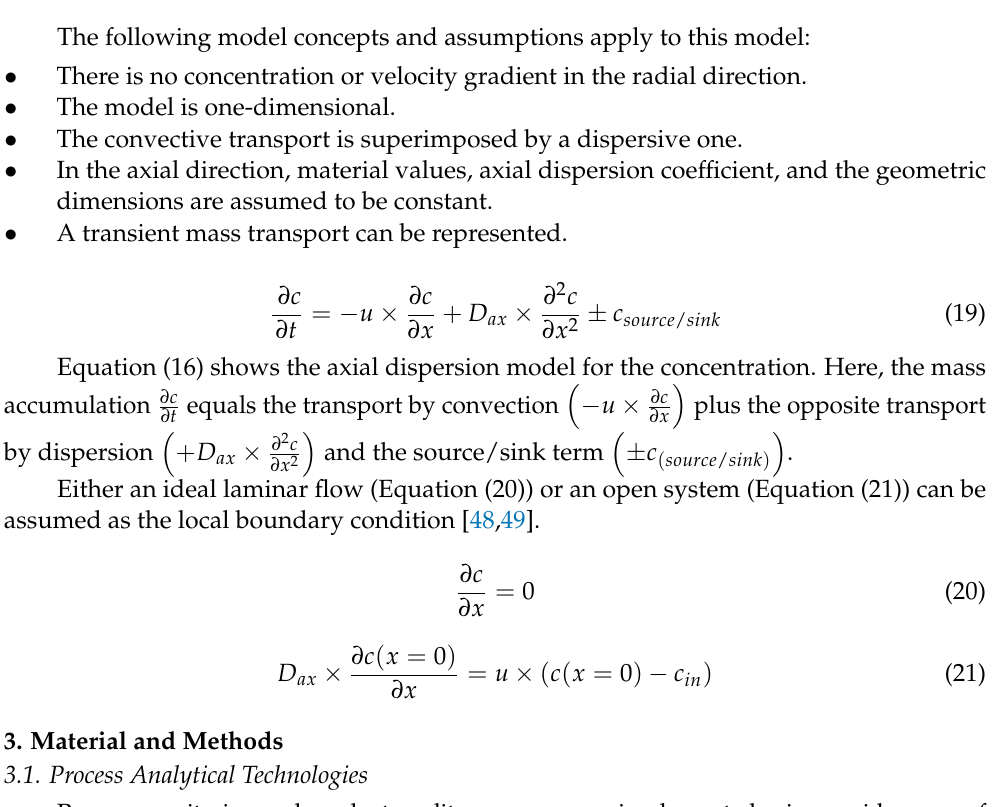
Figure 7. Schematic representation of the radial concentration distribution of ideal and real plug flow [48].